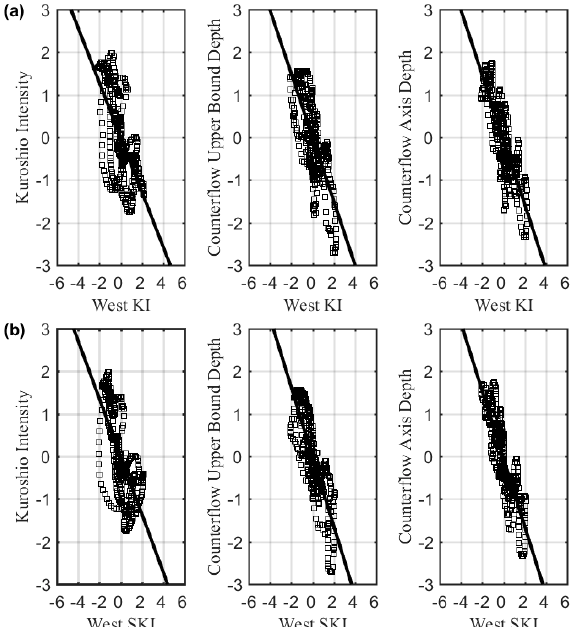
Figure 9. Scatter plots of standardized Kuroshio Intensity (INT), counter-flow upper boundary depth and counter-flow axis depth with the KI across the western continental slope (D1–D2, Figure 1) The INT was derived from satellite data along section K (Figure 1). The depths of the upper boundary and axis of the counter-flow were derived from in situ observations. ( a ) The West KI was derived from analysis data; ( b ) the West SKI was derived from satellite altimeter data. A 15-d low-pass filter was applied to the primary data. Locations of each section, segment points and in situ measurement sites are shown in Figure